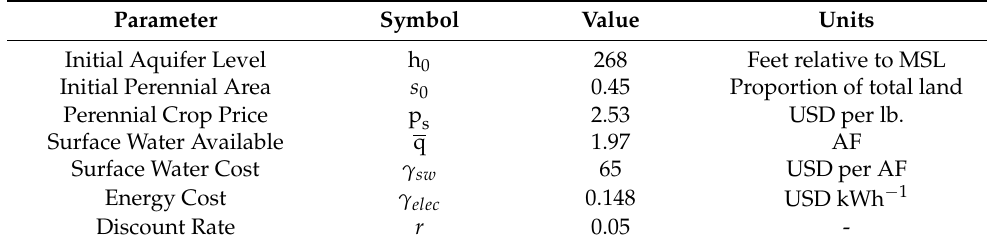
Table 5. Baseline parameter values.